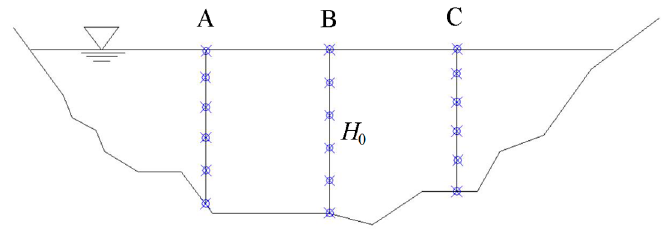
Figure 2. Sketch of measurement arrangement at a cross-section.